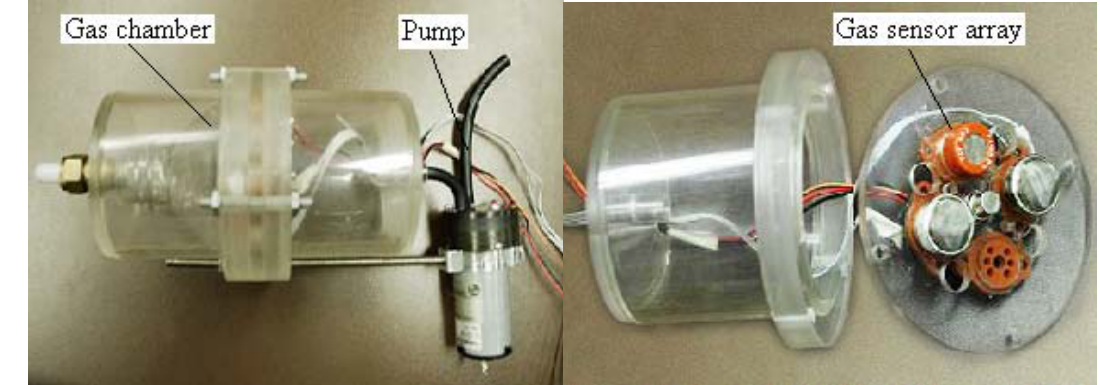
Figure 2. The gas chamber, pump and sensor array in the